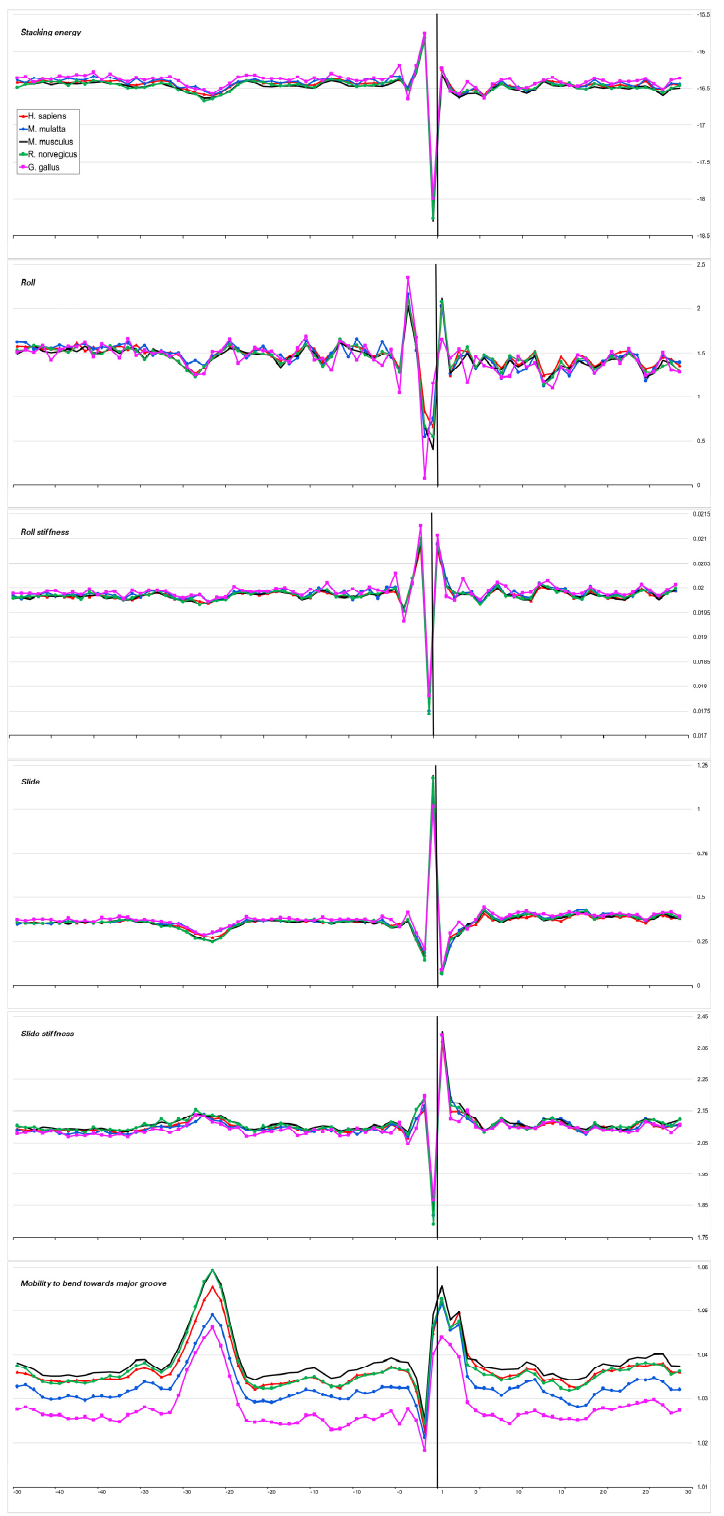
Figure 3. Local variations of the values of physical and structural parameters in core promoter regions of H. sapiens , M. mulatta , M. musculus , R. norvegicus , and G. gallus . ( a ) Stacking energy (in kcal/mol). ( b ) Roll (in degrees). ( c ) Stiffness of the duplex structure to Roll alteration (in kcal/mol degree). ( d ) Slide (in angstroms). ( e ) Stiffness of the duplex structure to Slide alteration (in kcal/mol angstrom). ( f ) Mobility to bend towards major groove (in mobility